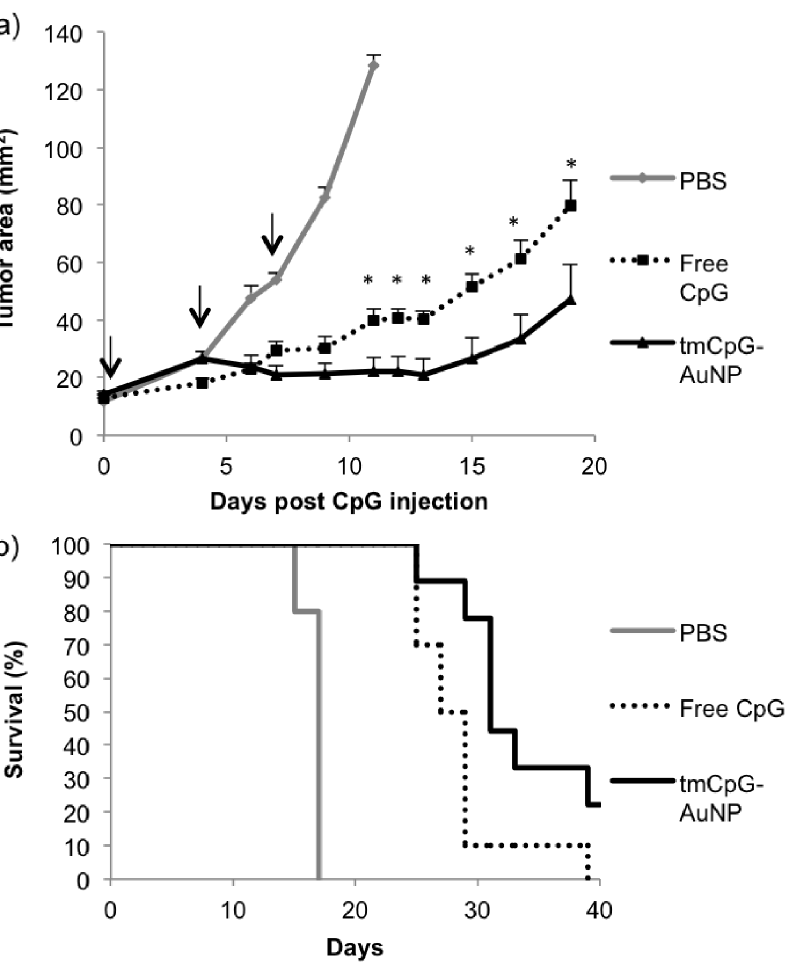
Figure 4. Invivo anti-tumor effect following intratumor injections on days 0, 4, and 7, as indicated (arrows), with PBS, free CpG or tmCpG- AuNP. (a) Tumor growth and (b) survival percentage after the first CpG injection (*p , 0.05).